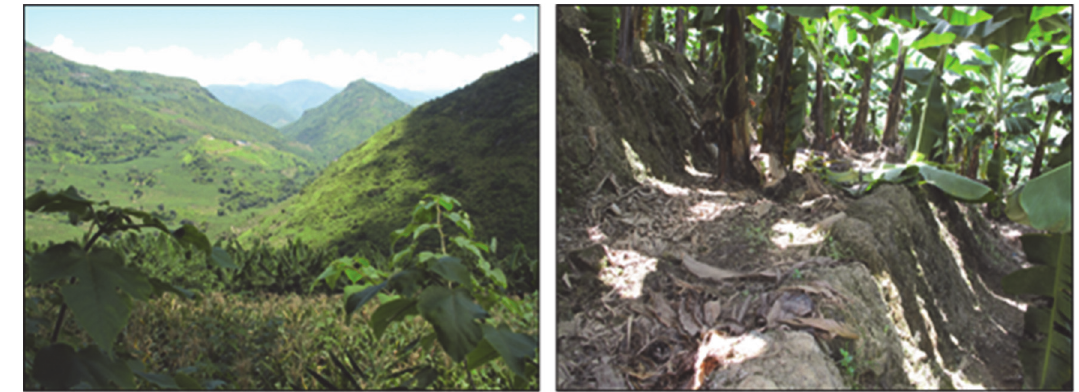
Figure 6. The shift from rice terraces to land for growing bananas in Gaocheng village.